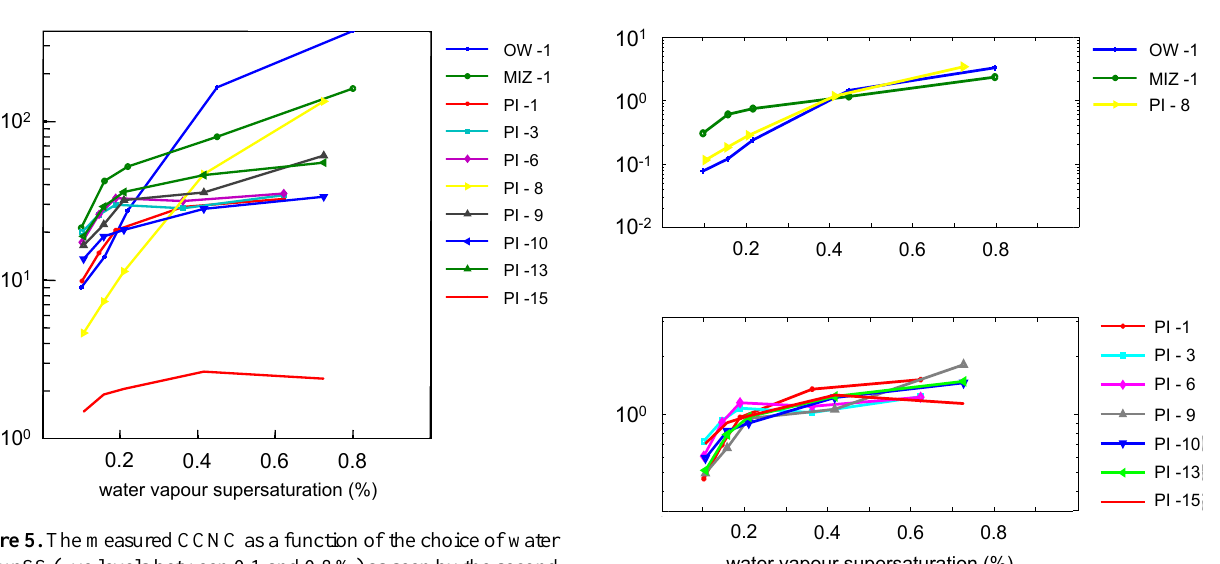
pospheric origin (cluster 3: Fig. 3c), (3) samples PI-1, PI-3, PI-6, PI-9, PI-10, PI-13 and PI-15 which all showed a small or non-existent continuous change in CCNC with increasing water vapour SS > 0.2 %. One common feature for five out of the seven impactor samples was that the sampled air spent a relatively short time over the ice (DOI ∼ 2) since last contact with open sea. The origin of the air during PI-1 and PI-6 (tra- jectory cluster 1: Fig. 3a) and PI-3, PI-9 and PI-10 (cluster 2: Fig. 3b) were easterly from the Barents and Kara seas and from the Fram Strait–Greenland Sea area. For the remaining two samples PI-13 (cluster 4: Fig. 3d) and PI-15 (cluster 5: Fig. 3e), the air was advected over the pack ice for more than 6 days since contact with open